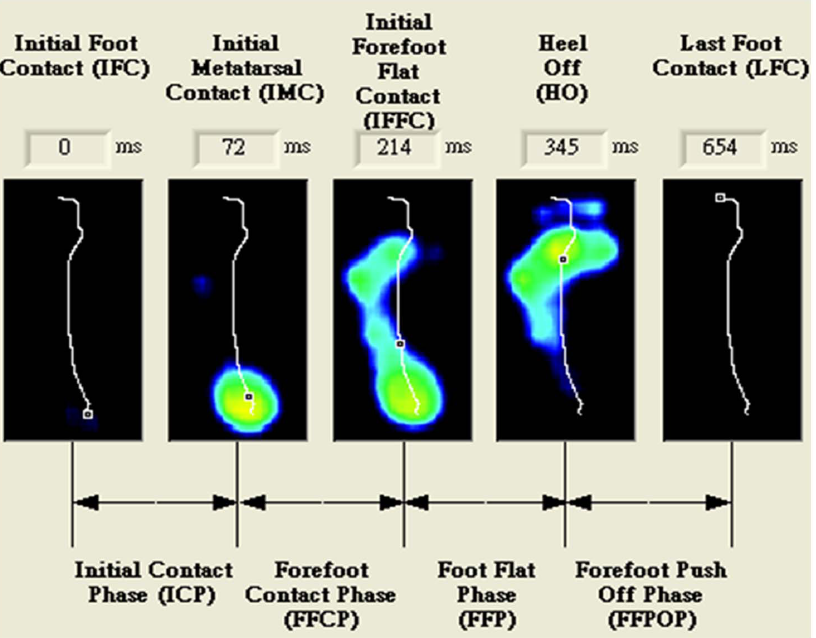
Figure 1. The representative figure for definition of the four subphases of the stance phase in walking.